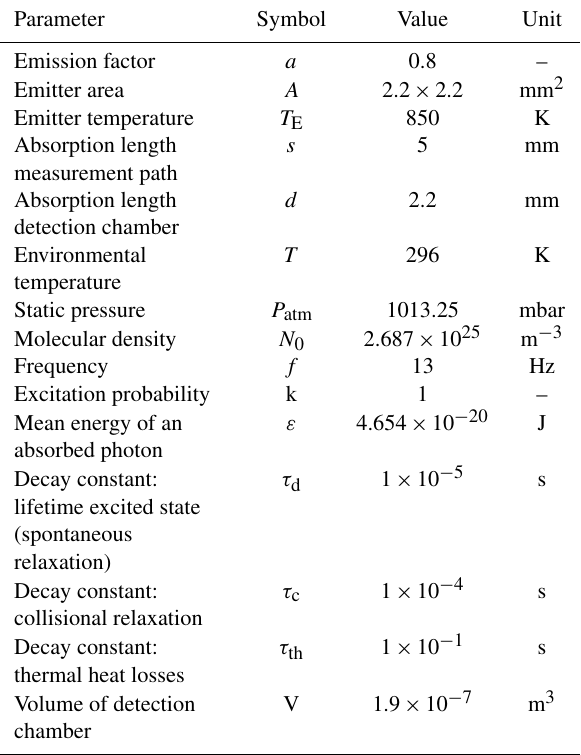
Table 1. Parameters used in the simulation model.